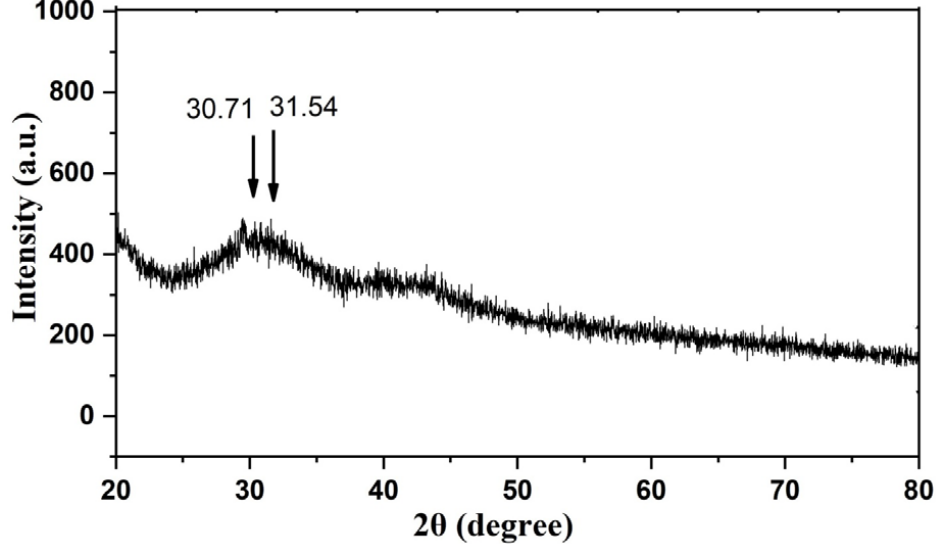
Figure 3. XRD pattern of Cu -Mn bimetallic nanoparticles.